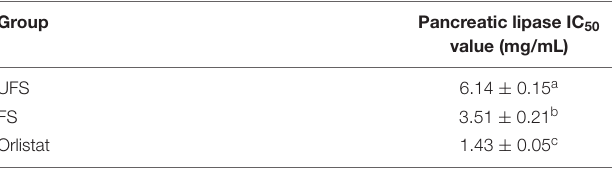
TABLE 2 | Lipase inhibition activity of unfermented seaweed extracts and fermented seaweed